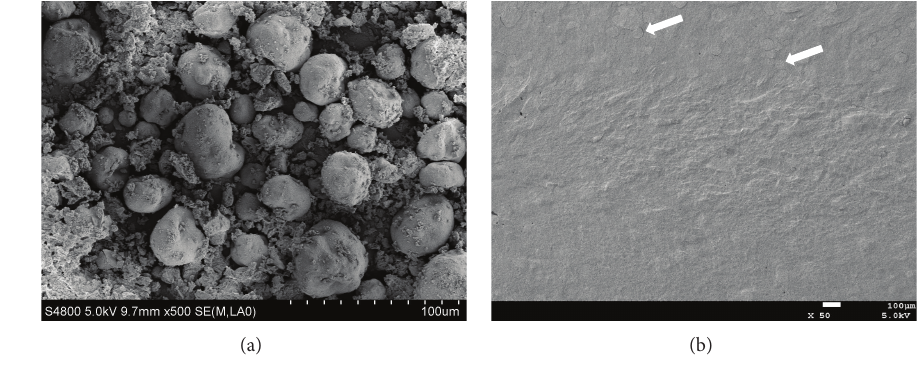
Figure 3: The morphology of s-HA (a) and s-HA/PA (b).